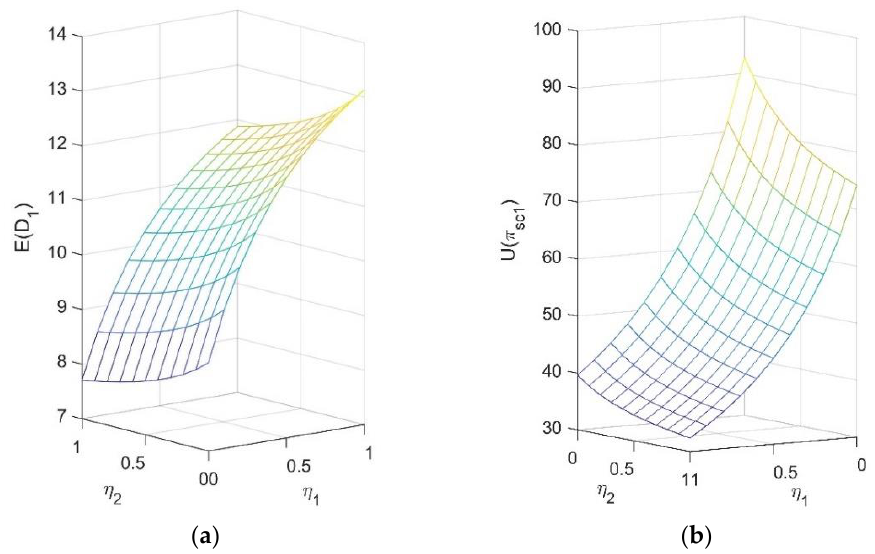
Figure 2. SC1 expected demand and total expected utility change with the degree of risk aversion, ( a ) Expected demand changes with η i . ( b ) Total expected utility changes with η i .